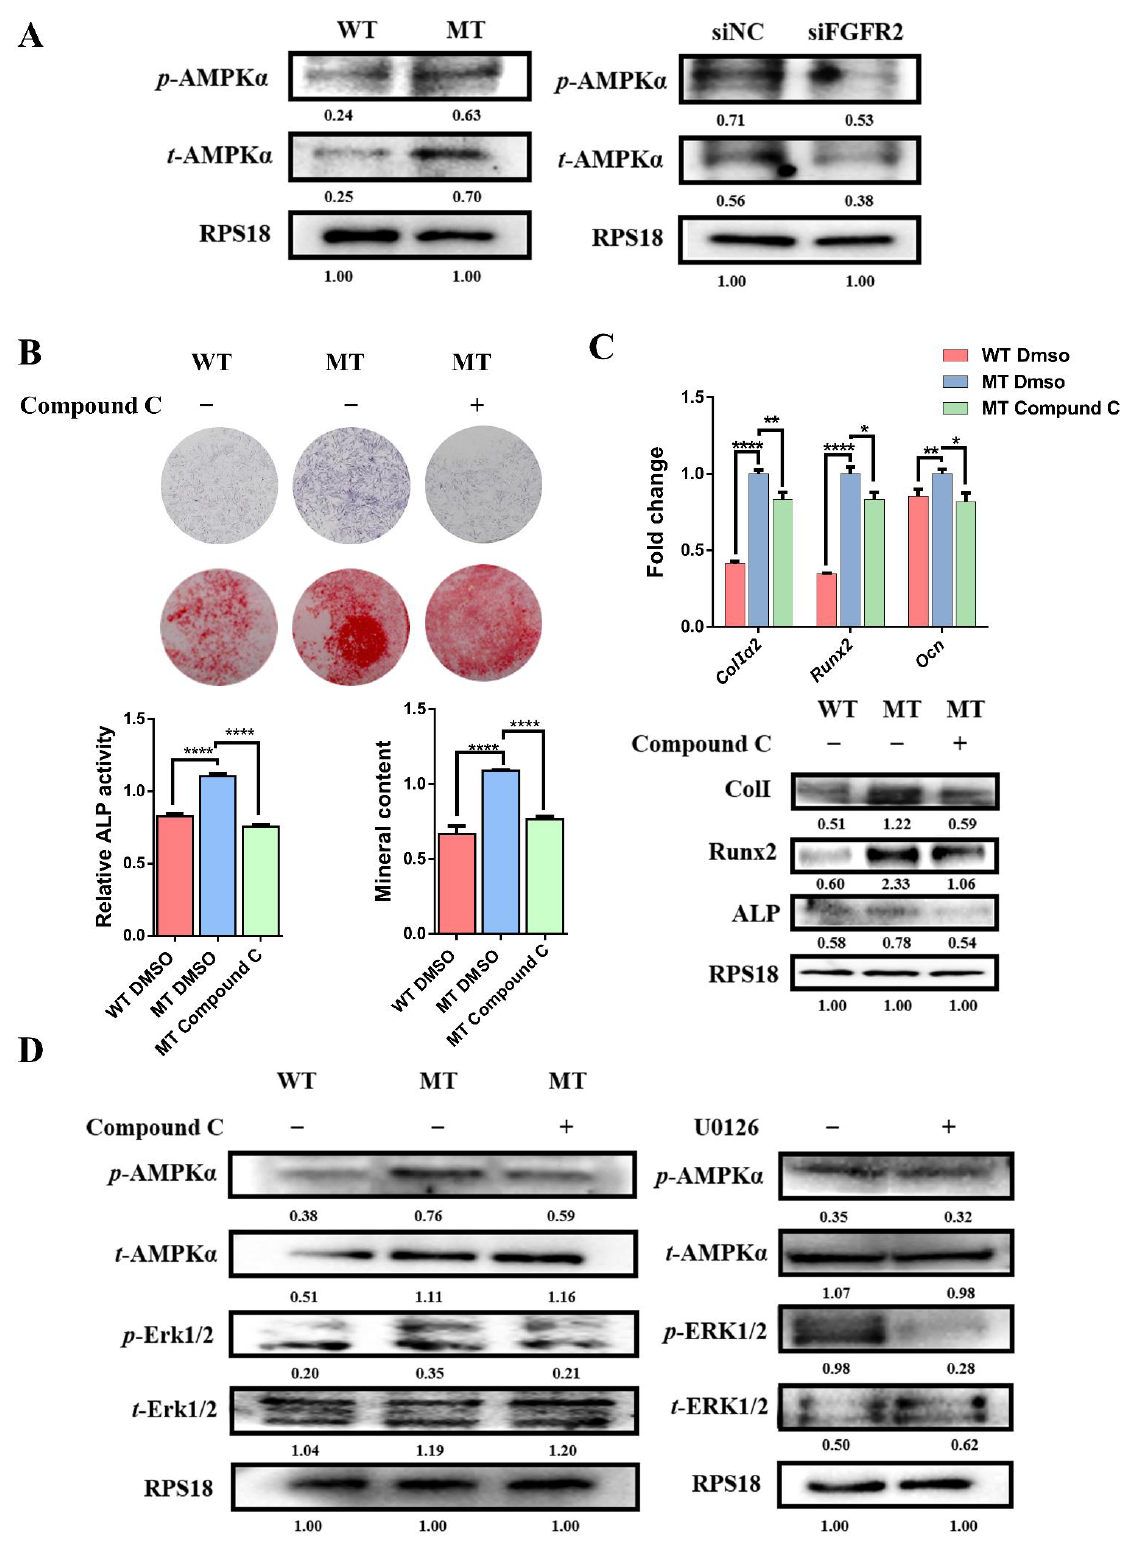
Figure 5. The activation of the AMPK-Erk pathway contributed to dysregulating osteogenesis by FGFR2 p.Cys342Arg: ( A ) Western blot analysis showed that the expression of t -AMPK and p -AMPK were upregulated in the MT group compared with the WT group and the expression of t -AMPK and p -AMPK were downregulated in the siFGFR2 group compared with the control. ( B ) ALP